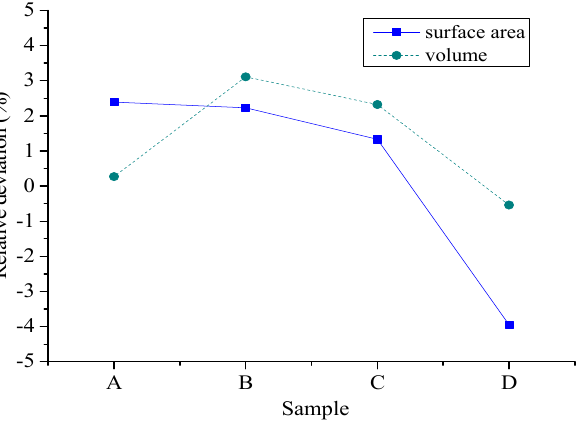
Figure 16. The relative deviation of the volume indicators of natural aggregates and cement-based artificial aggregates.